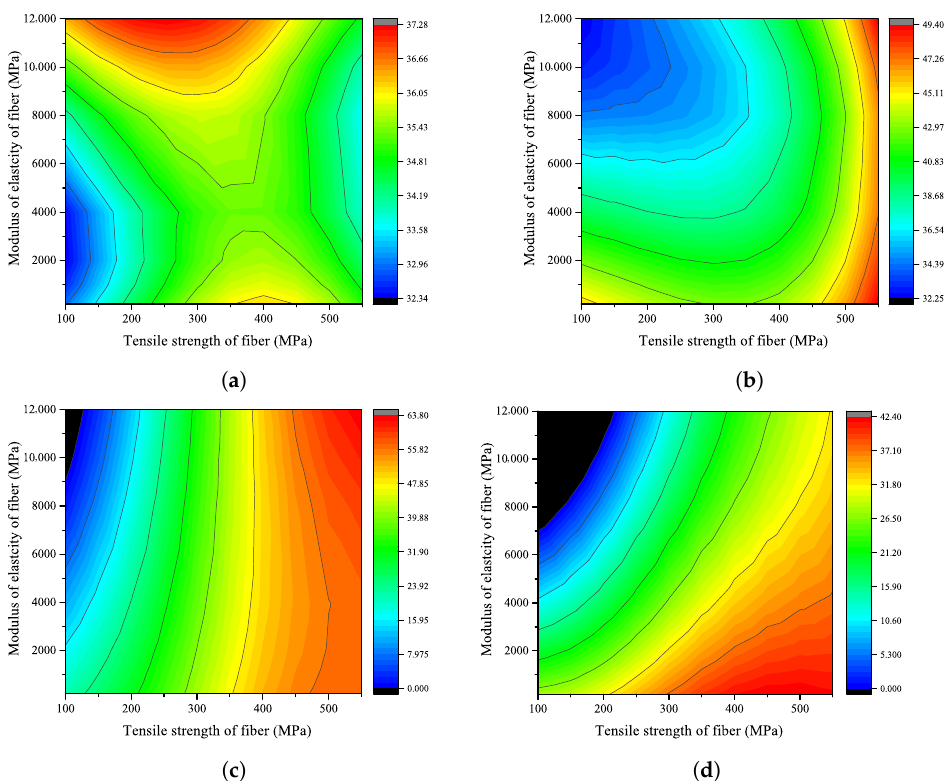
Figure 7. Variations of the 28-day compressive strength for different PET fibers, based on tensile strength, modulus of elasticity, and fiber shapes. ( a ) String shape, ( b ) Irregular shape, ( c ) Deformed shape, and ( d ) Embossed